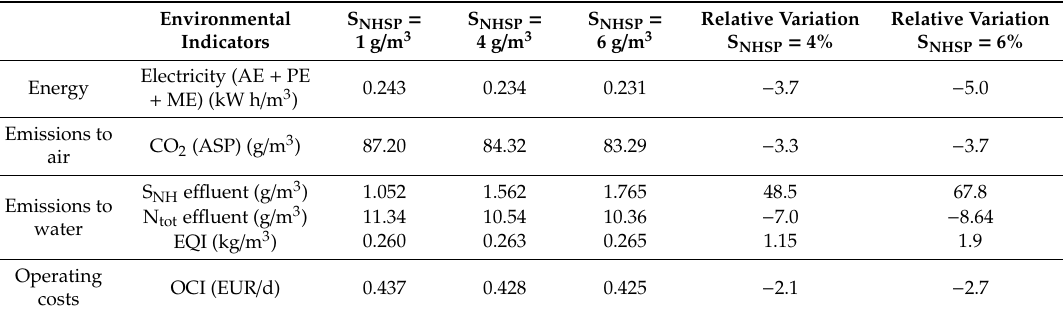
Table 7. Annual values of environmental indicators and operating costs of a BSM2 plant with respect to the volume of treated wastewater using the ammonium-based control scheme (Cascade S NHSP ) with di ff erent set-points and variation relative to 1 g / m 3 set-point.